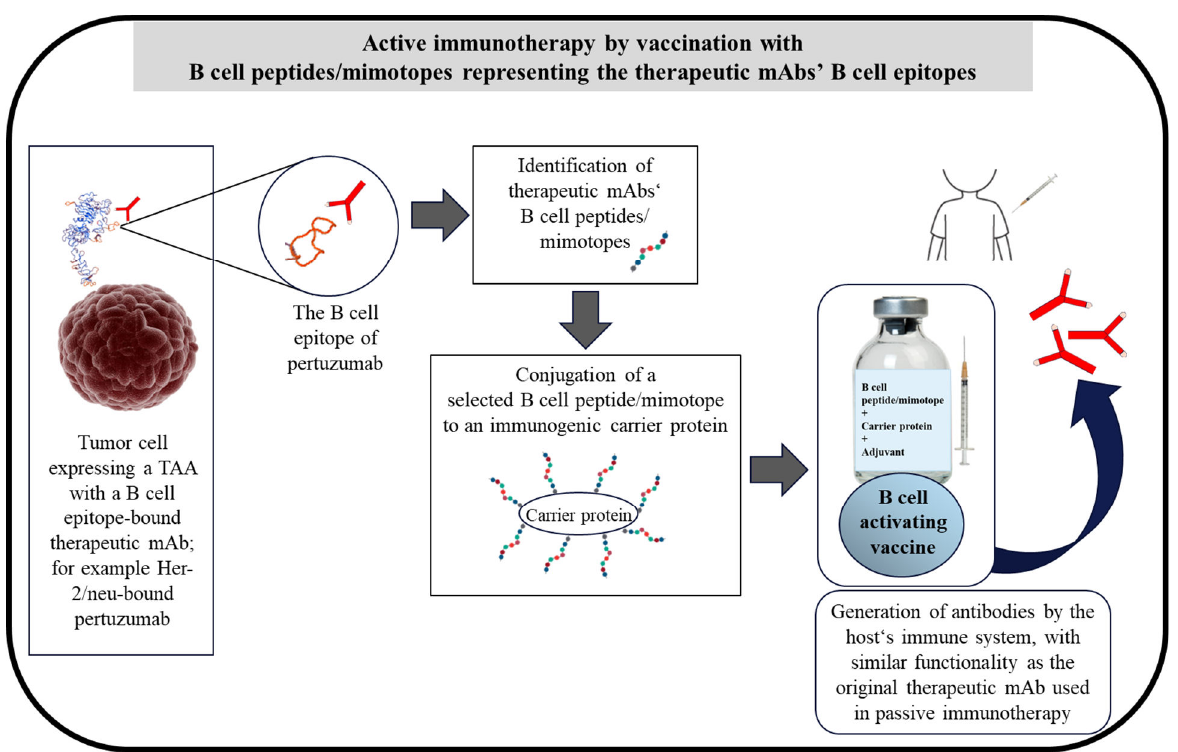
Figure 2. Schematic description of active immunotherapy with B cell peptides/mimotopes representing the B cell epitopes of therapeutic mAbs on TAAs, for example, a B cell peptide/mimotope of pertuzumab. The binding epitope of pertuzumab indicates the mAb B cell epitope on Her-2/neu. B cell peptides/mimotopes representing the mAb binding epitopes are identified, as described in the text and previously [62,101–103]. The selected B cell peptide/mimotope of the mAbs is conjugated to an immunogenic carrier protein, and an admixture-based vaccine comprising the conjugate and an adjuvant is then formulated. The formulated vaccine directly activates B cells for the production of antibodies in the host. The production of the antibodies is also induced further by the presence of T cell epitopes in the carrier protein, resulting in stimulation of T cells and further activation of B cells. The endogenously produced antibodies have the same functionality and modes of action as the respective therapeutic mAbs, such as pertuzumab. Adapted with permission from Ref. [62]. Elsevier, 2022.